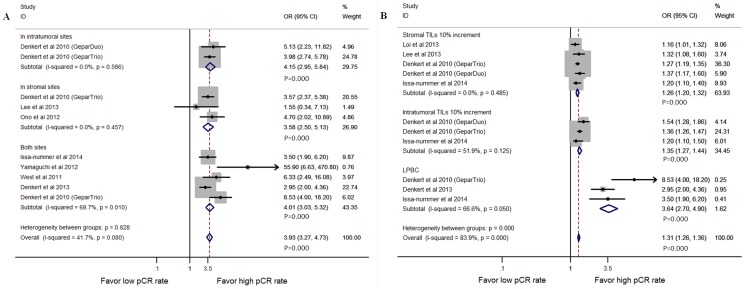
Forest plots from the fixed-effect meta-analysis of the efficacy of TILs on the NAC response stratified by infiltration locations (A) and different cutoff values (B).The width of horizontal line represents 95% CI of the individual studies, and the grey boxes represent the weight of each study. The diamond represents the overall summary estimate. The unbroken vertical line was set at the null value (HR = 1.0). Abbreviations: LPBC, lymphocyte-predominant breast cancer; TILs, tumor infiltrating lymphocytes.